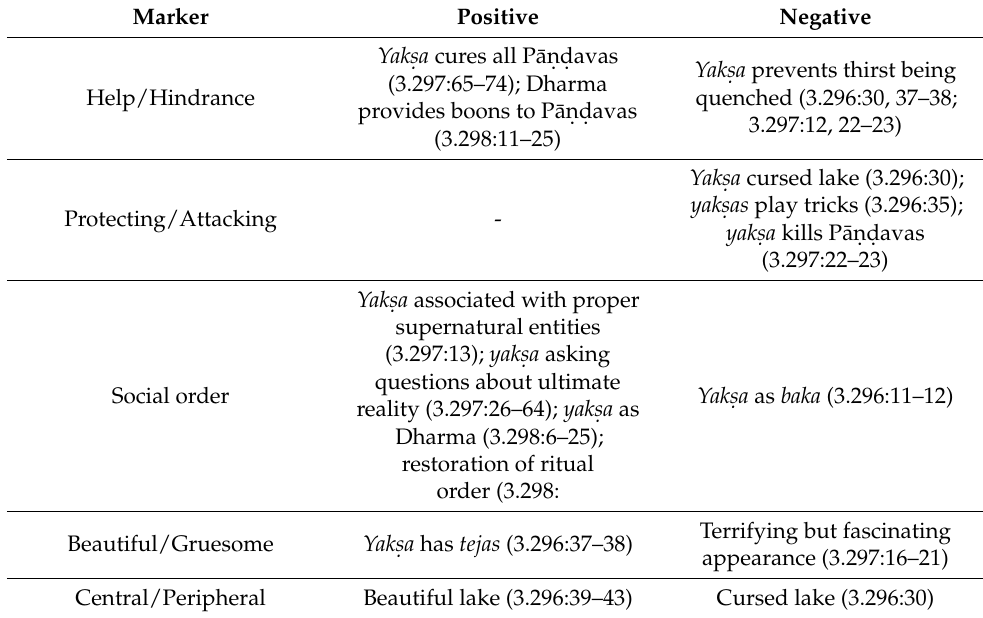
Table 4. evaluation of the yaks.a in the story of the Drilling Woods. Marker Positive Negative